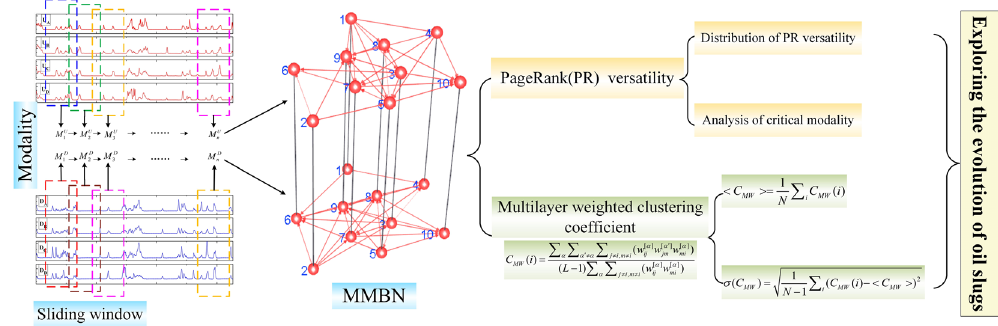
Figure 2. A schematic diagram of our analytical framework for exploring the evolution of oil slugs. We give a simplified MMBN with 10 nodes here for